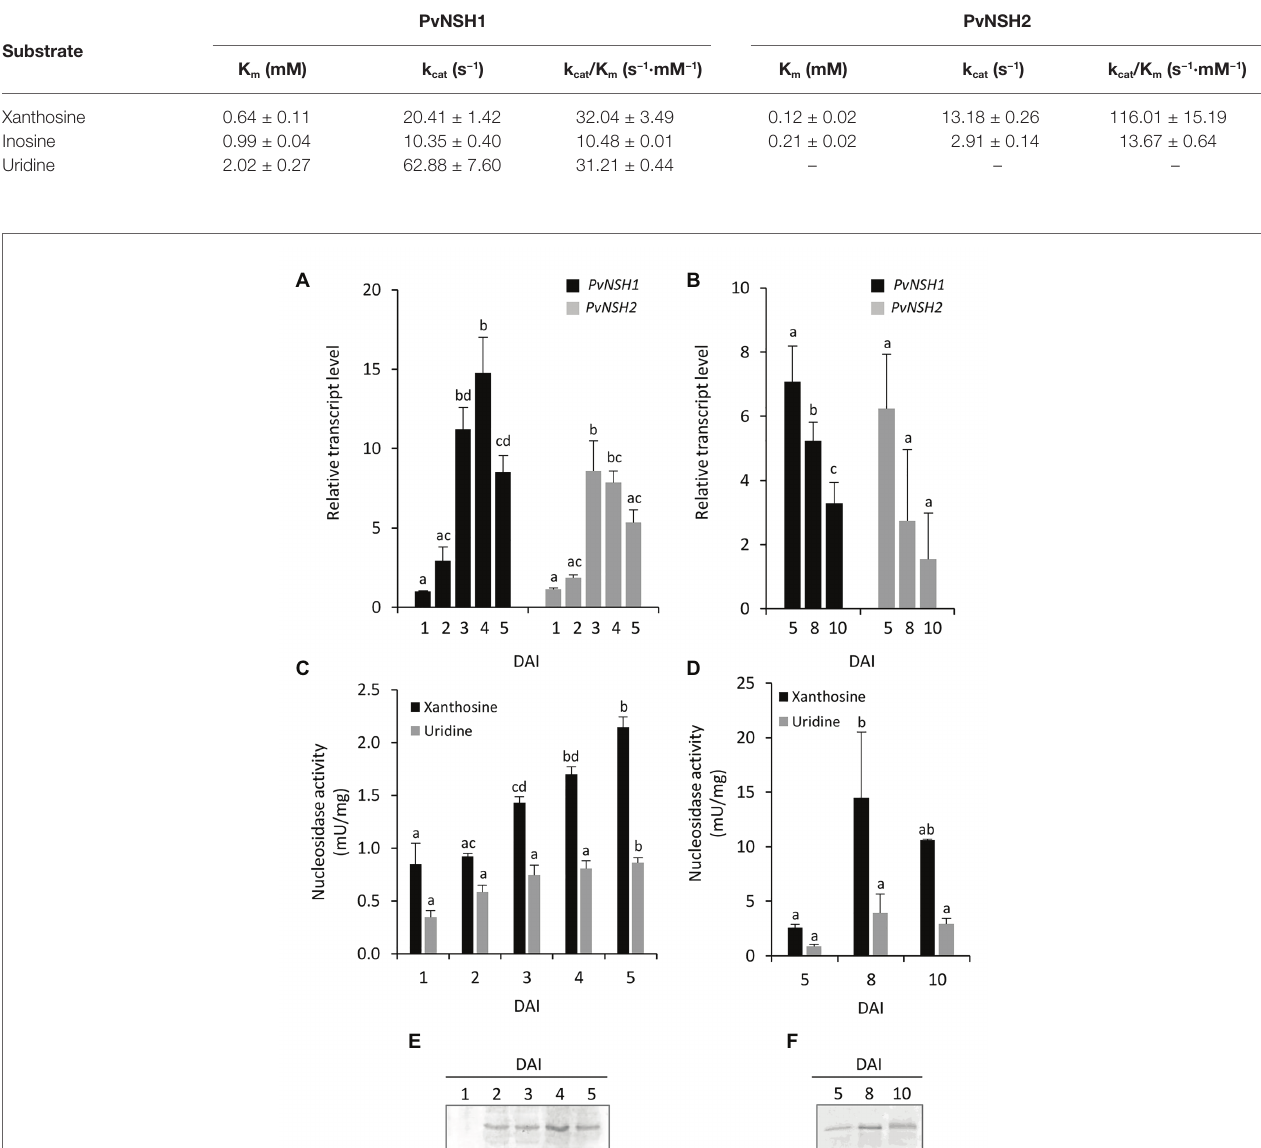
TABLE 2 | Kinetics parameters for PvNSH1 and PvNSH2.